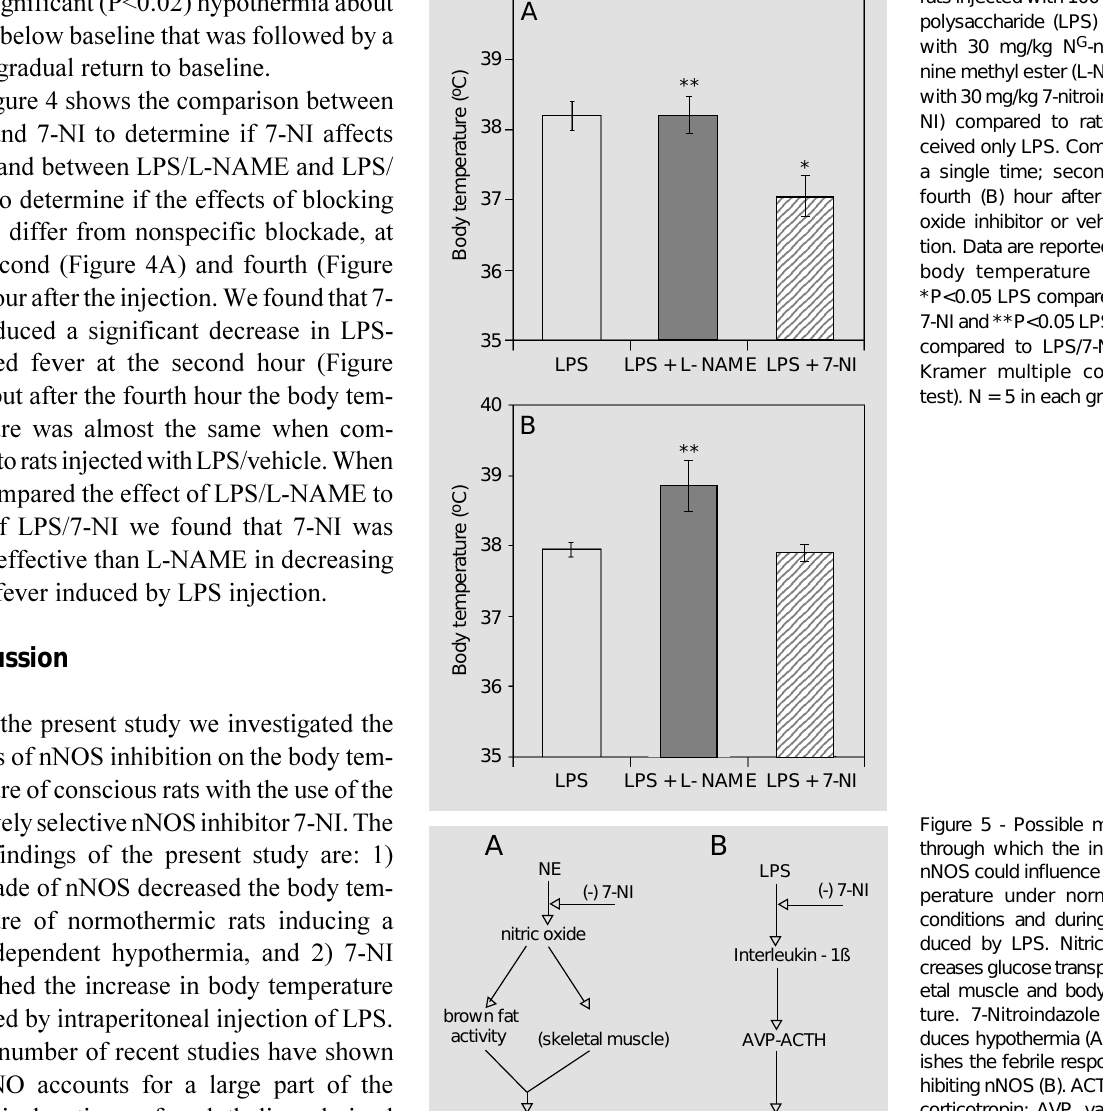
Figure 5 - Possible mechanism through which the inhibition of nNOS could influence body tem- perature under normothermic conditions and during fever in- duced by LPS. Nitric oxide in- creases glucose transport in skel- etal muscle and body tempera- ture. 7-Nitroindazole (7-NI) in- duces hypothermia (A) and abol- ishes the febrile response by in- hibiting nNOS (B). ACTH, Adeno- corticotropin; AVP, vasopressin; NE, norepinephrine; (-), inhibition of nitric oxide